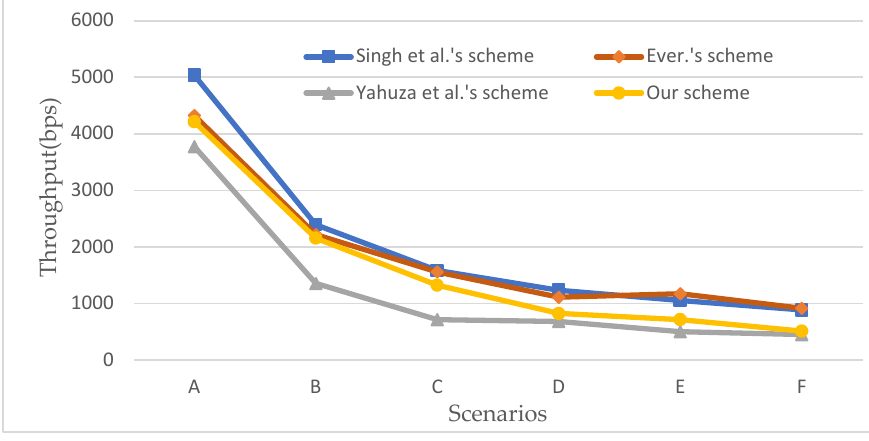
Figure 11. Comparison of throughputs among different schemes.